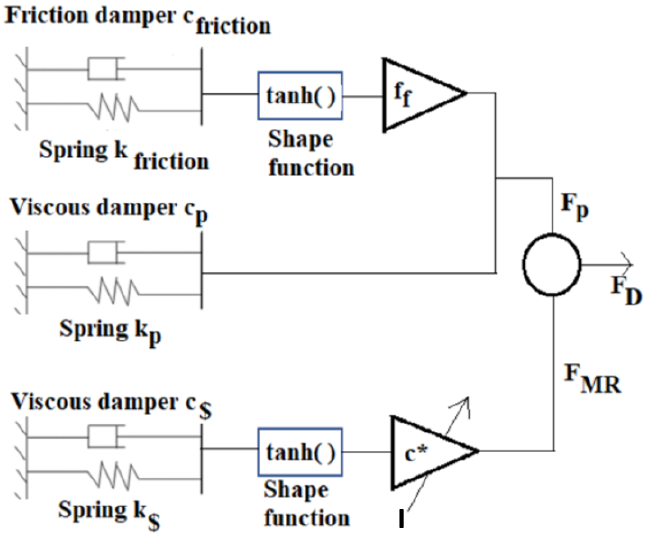
Figure 4. MR model. c* means c MRpostyield